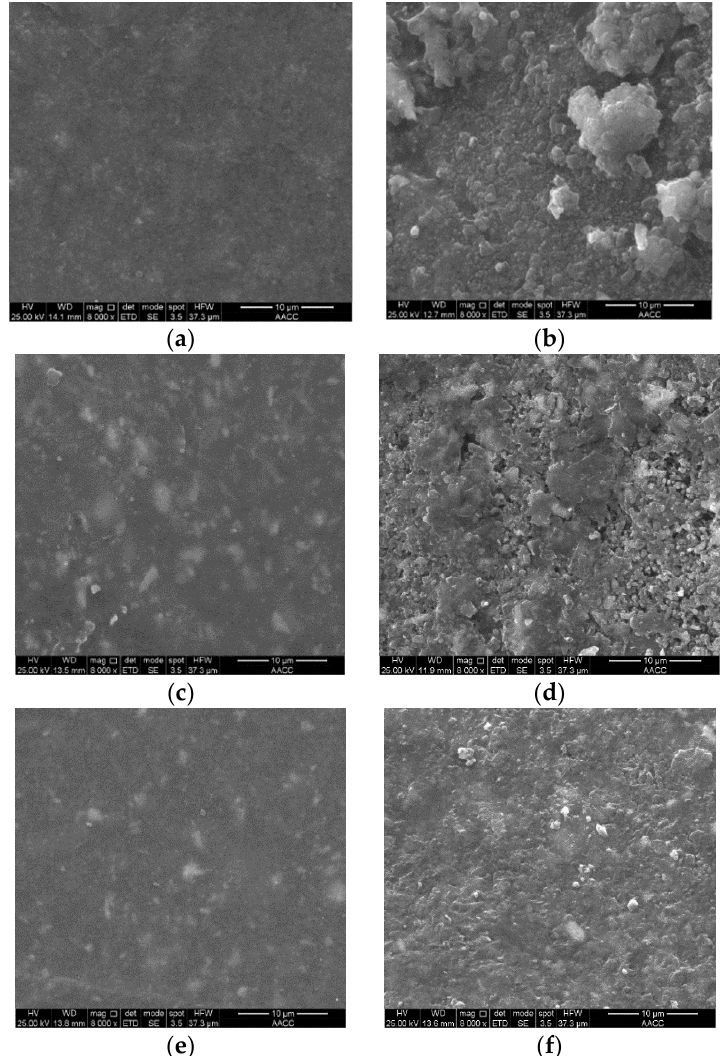
Figure 5. SEM pictures of nano-TiO 2 modified coatings before and after ultraviolet radiation. ( a ) Before aging (CRT); ( b ) after aging (CRT); ( c ) before aging (EPT); ( d ) after aging (EPT); ( e ) before aging (PUT); ( f ) after aging (PUT).